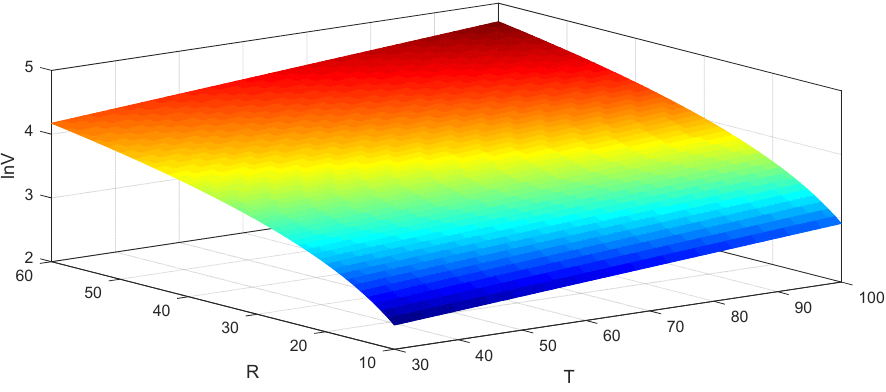
Figure 8. Output voltage under continuous parameters.